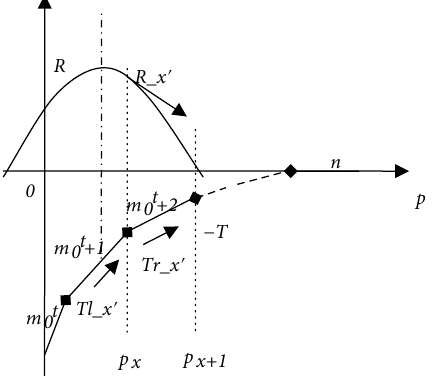
Figure 5: The revenue function and the tardiness